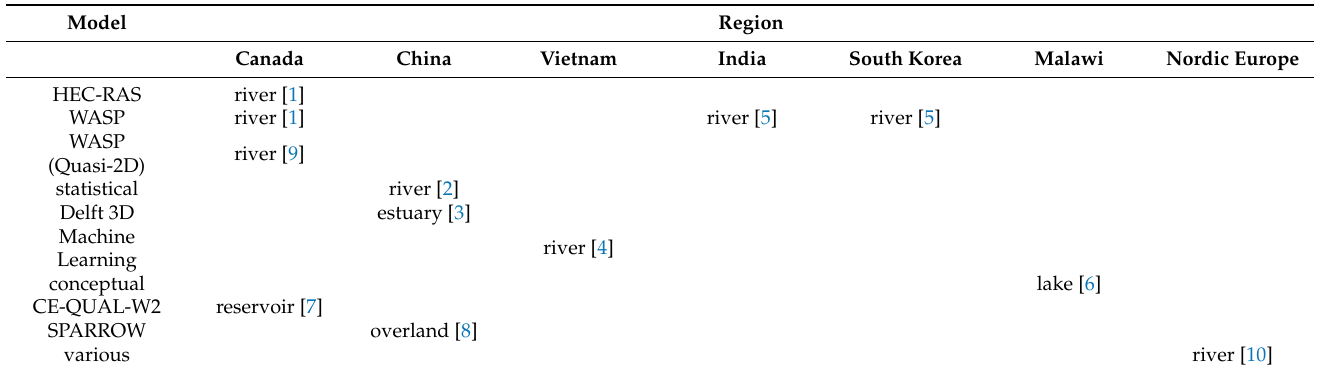
Table 1. Summary of the models used, surface waters investigated and study regions of the articles in this Special Issue, Surface Water Quality Modelling